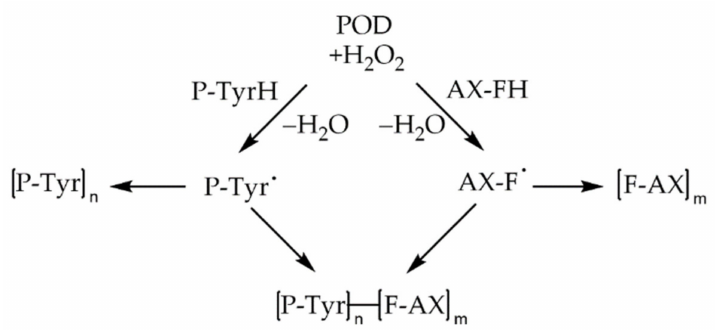
Figure 10. Proposed mechanism of the chemoenzymatic crosslinking between proteins and AX via reactive tyrosine and FA residues. Modified from Boeriu et al.